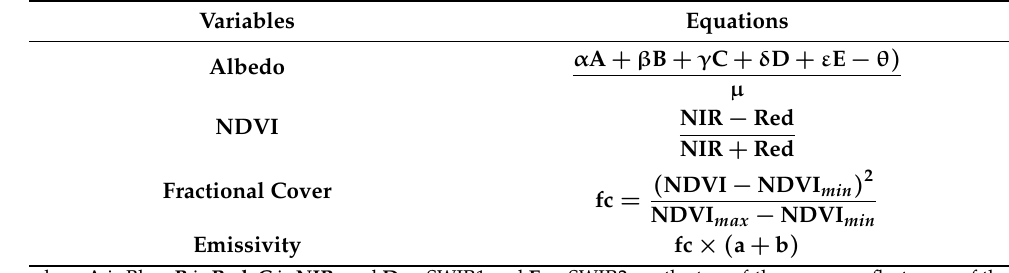
Table 2. List of equations used for deriving input variables from Landsat data for the Surface Energy Balance System (SEBS) model processing. Variables Equations Albedo